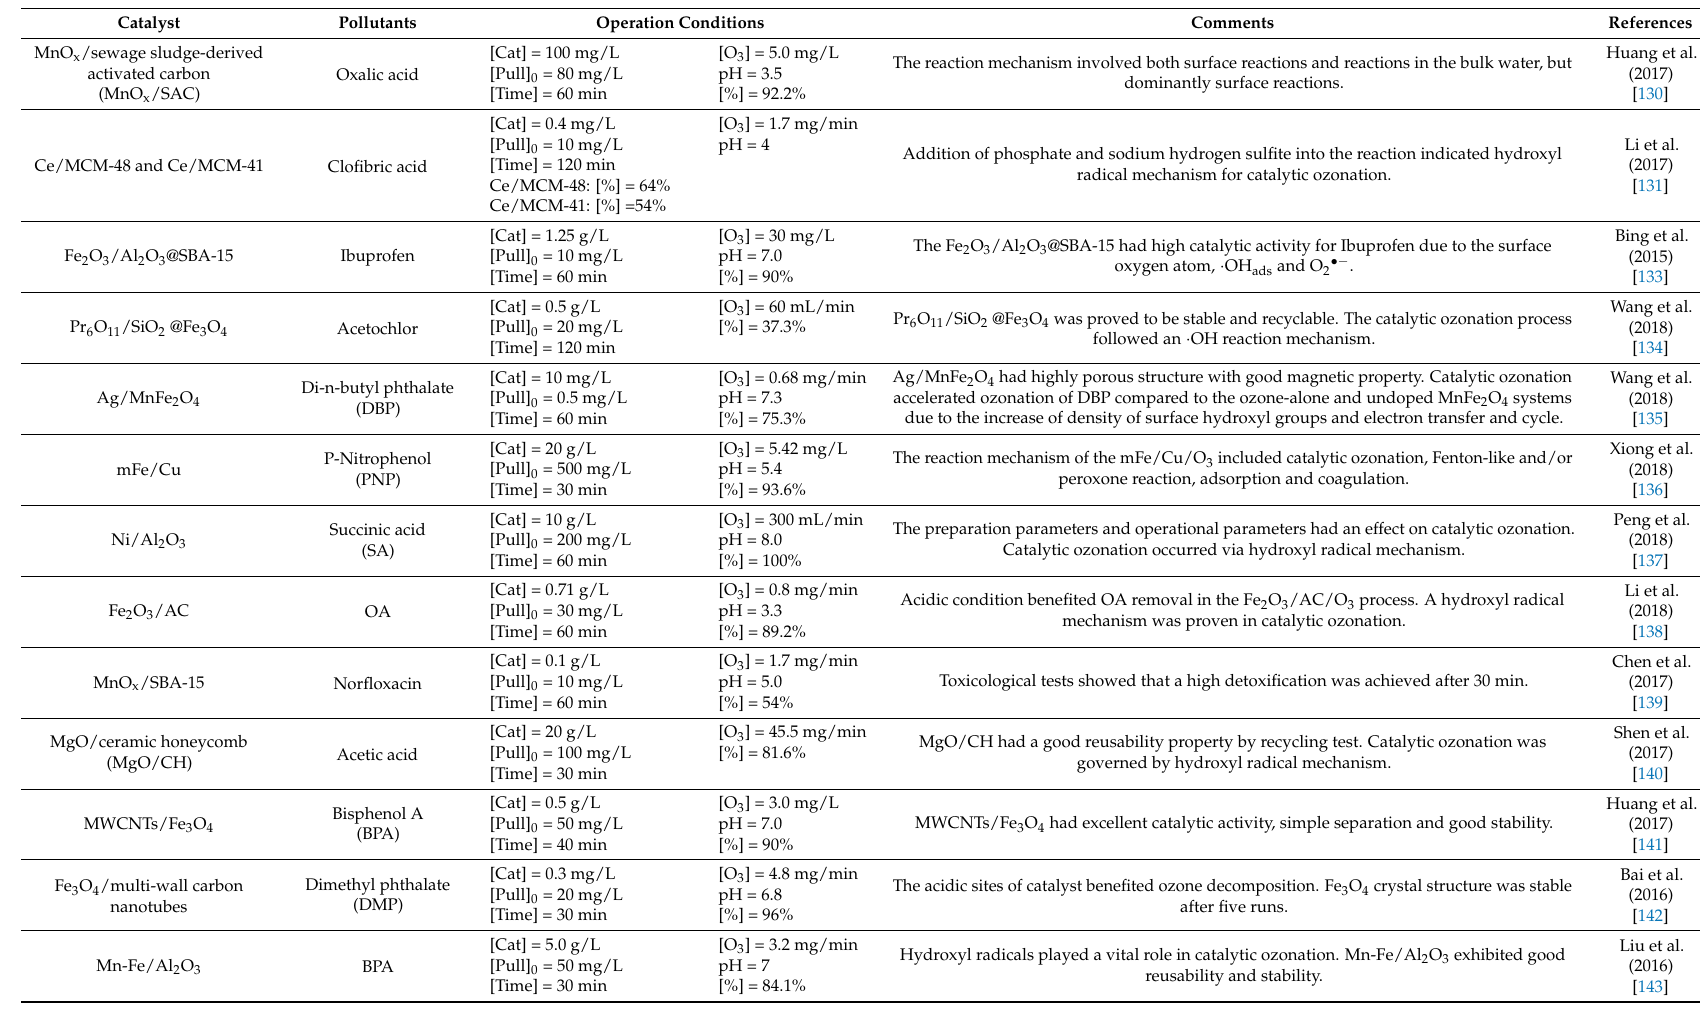
Table 9. Metals or metal oxides supported on oxides for catalytic ozonation